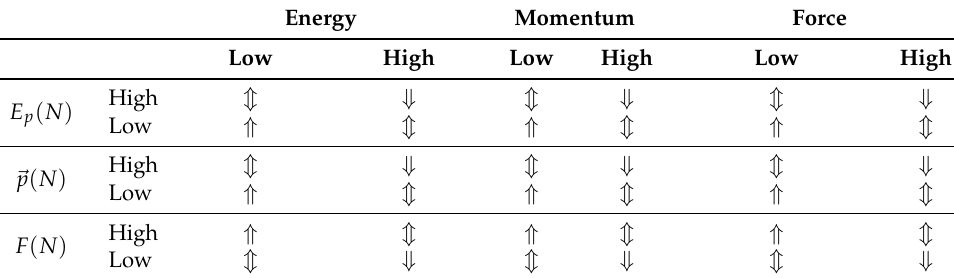
Table 4. Analogical link between motions in mind and physics.